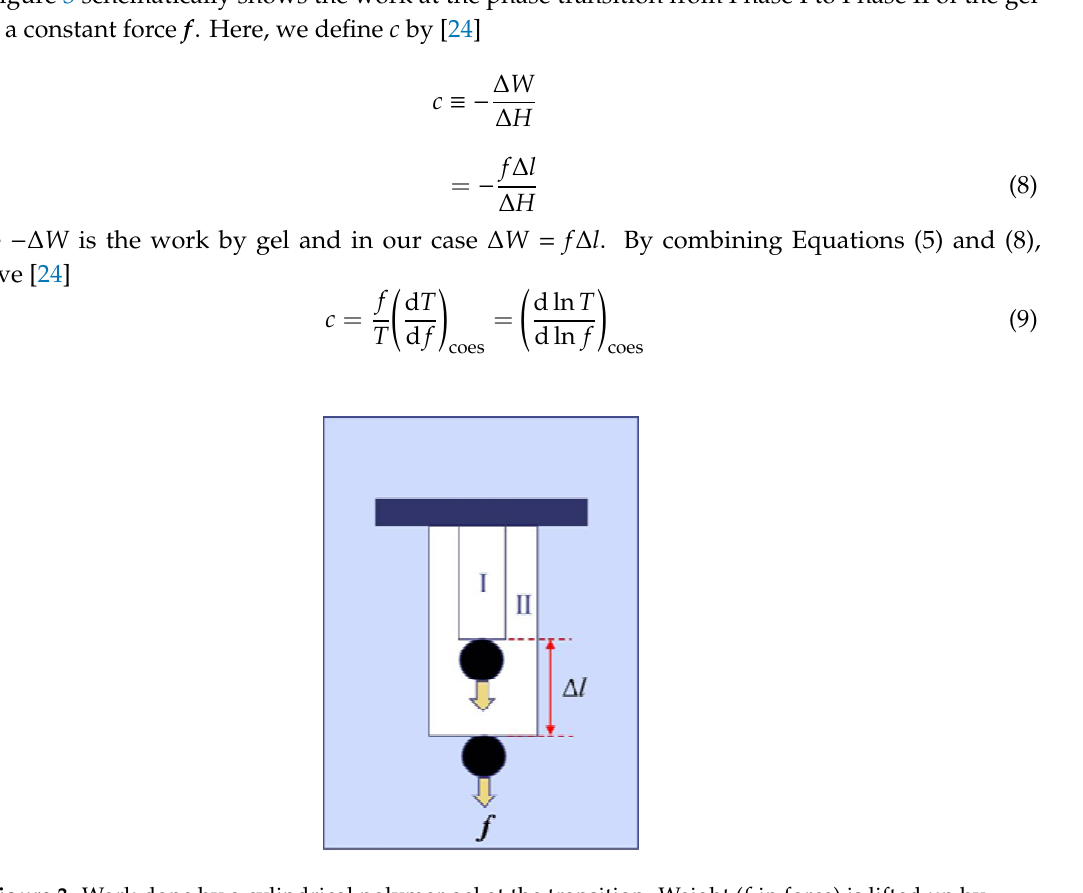
Figure 3. Work done by a cylindrical polymer gel at the transition. Weight ( f in force) is lifted up by ∆ l through the collapsing process. Phase I and Phase II correspond to collapsed and swollen phases, respectively, as is the case of Figure 1.